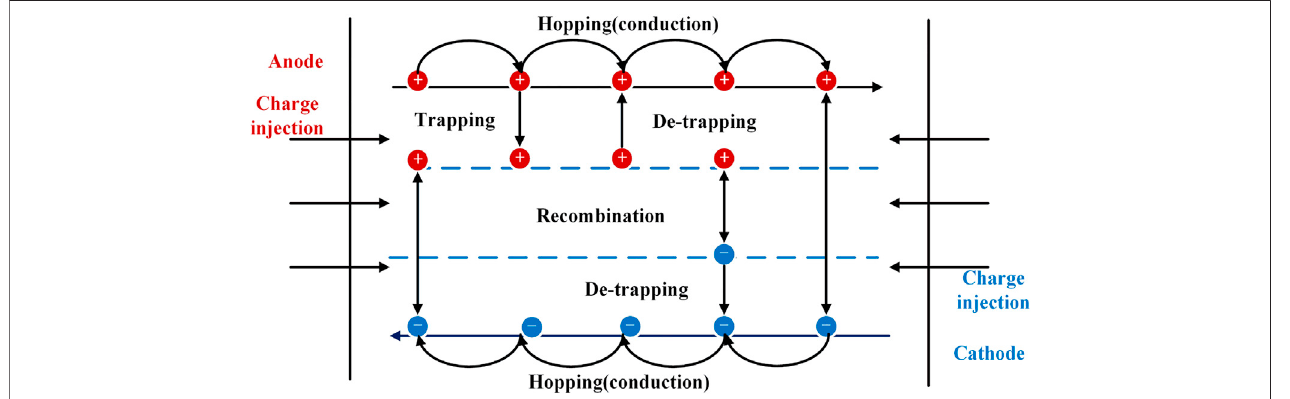
FIGURE 1 | Schematic diagram of bipolar charge